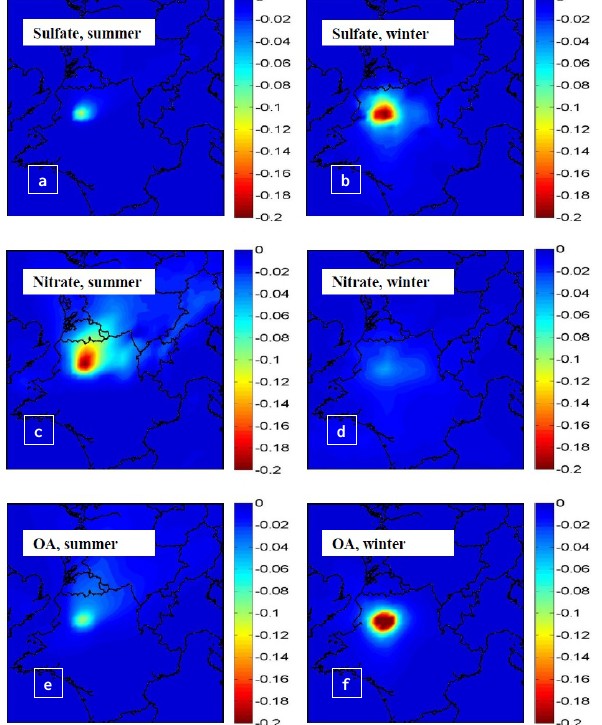
Figure 6. Simulated fractional decrease in PM 2 . 5 sulfate ( a , b ), ni- trate ( c , d ), and organic aerosol (OA; e , f ) levels for the summer ( a , c , d ) and winter ( b , d , f ) during the MEGAPOLI campaign period, when Paris agglomeration emissions are set to zero in the PMCAMx model.